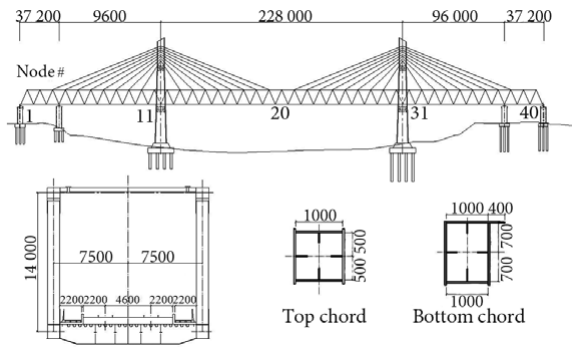
Fig. 1. Example bridge for this study, in mm